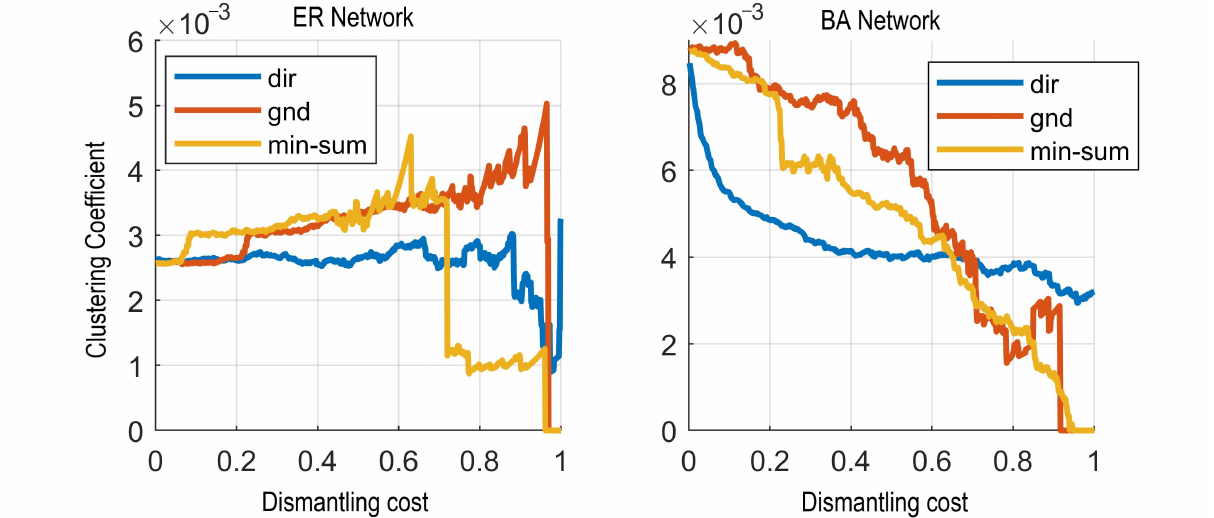
Figure 4. Curve graph of disassembly cost and clustering coefficient of directed ER random network and directed BA random network.